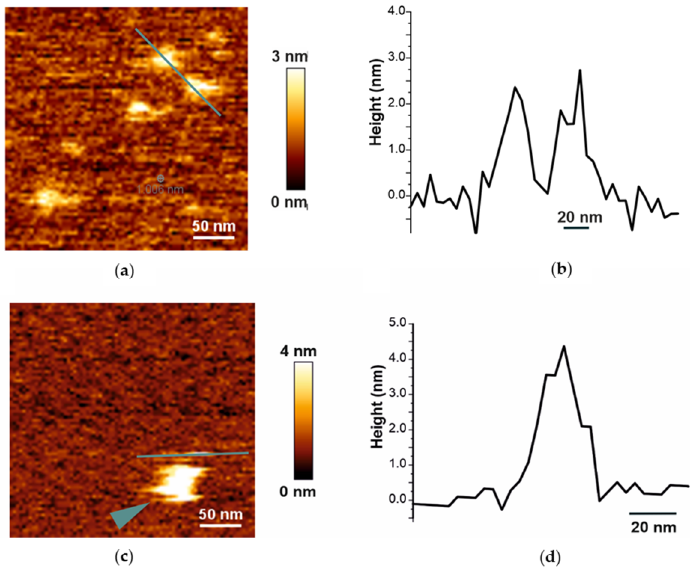
Figure 3. Atomic force microscopy (AFM) analysis of DIBMA/DMPC nanoparticles. ( a , c ) AFM images of DIBMA/DMPC nanoparticles prepared at 1:1 DIBMA/lipid weight ratio. The arrowhead indicates the presence of lipid nanoparticle stacks. ( b , d ) Height profile corresponding to the green line in the 2D image in ( a , c ) crossing individual lipid nanoparticles. The images are representative of at least two independent experiments.